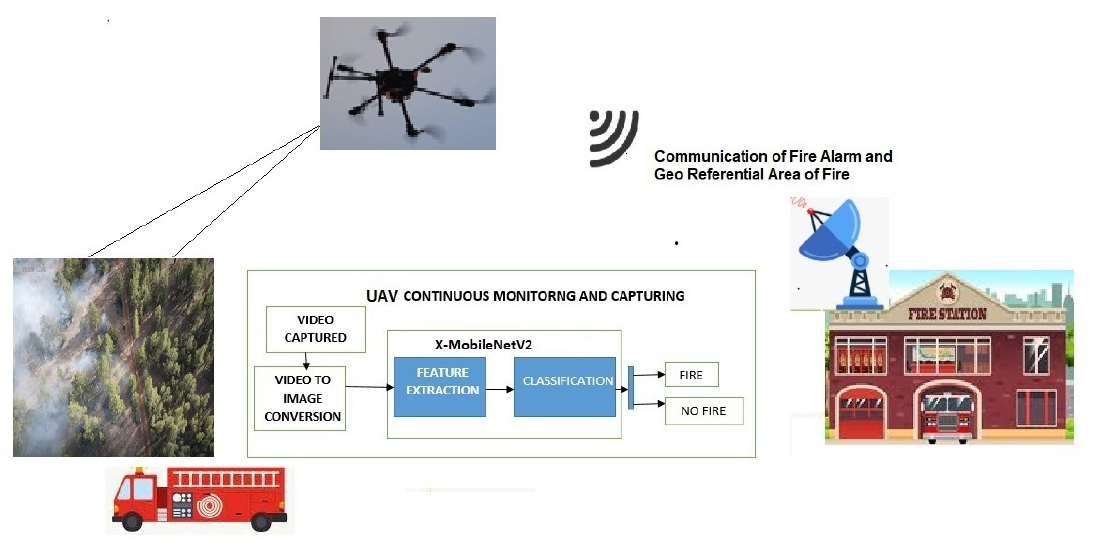
Figure 1. Workflow of forest fire